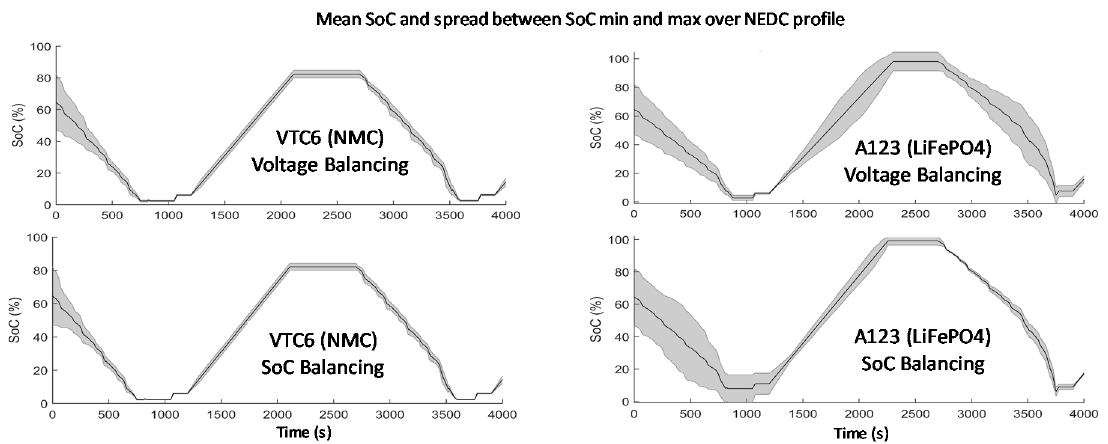
Figure 10. State of Charge dispersion over NEDC profile.